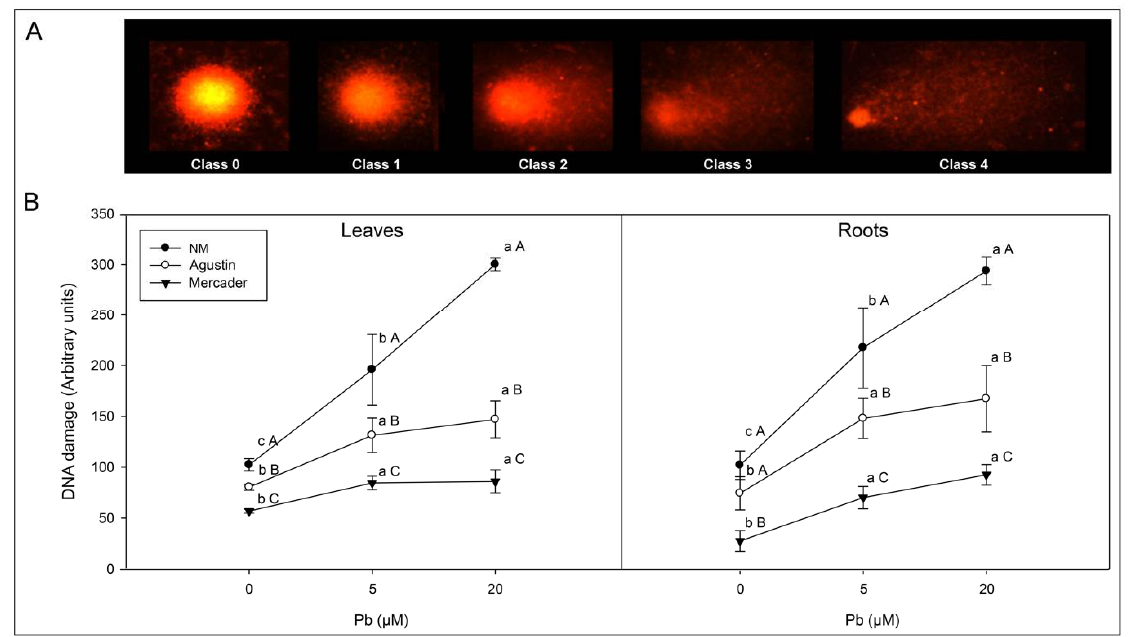
Figure 3. Levels of DNA fragmentation visualized by comet assay in Z. fabago exposed to Pb ( A ). DNA damage ( B ) in leaves and roots of Z. fabago seedlings from non-mining (NM) and mining areas (Agustin and Mercader) exposed to 5 and 20 µM Pb(NO 3 ) 2 during 4 weeks. Values are given as mean ± SE. For each class, different lowercase and uppercase letters mean significant differences between Pb treatments (within the same population) and populations (within the same Pb dose) ( p < 0.05), respectively.